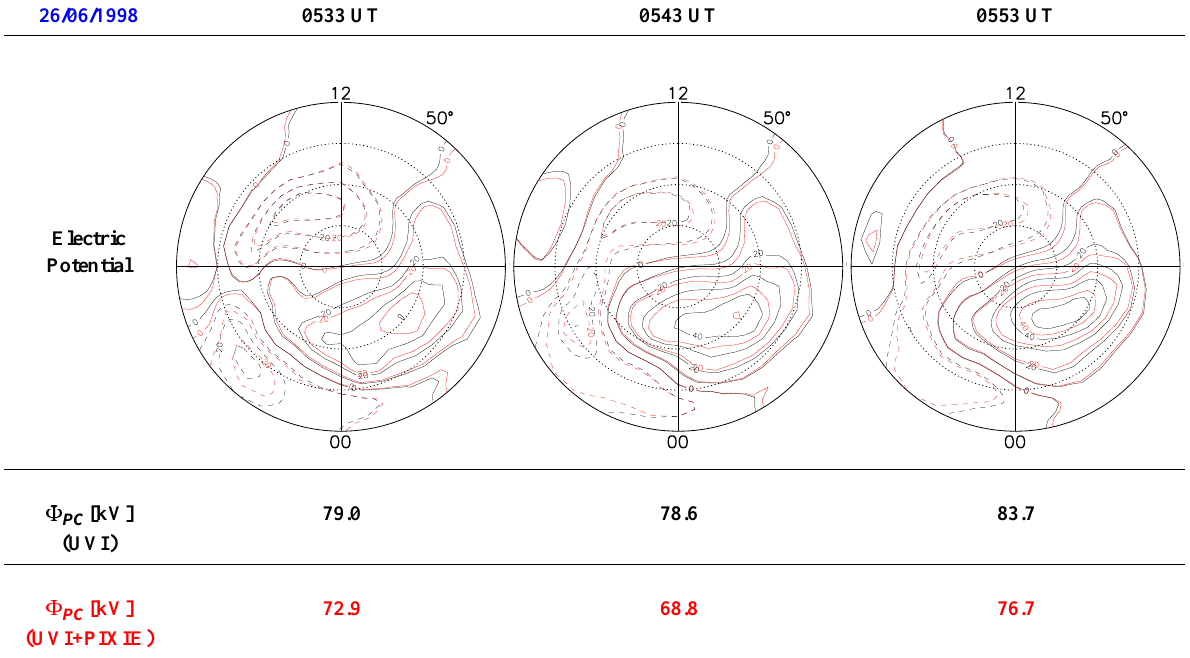
Fig. 4. Polar plots of the electric potential derived without (black contour lines) and with (red contour lines) PIXIE data between 05:30 and 06:00 UT on 26 June